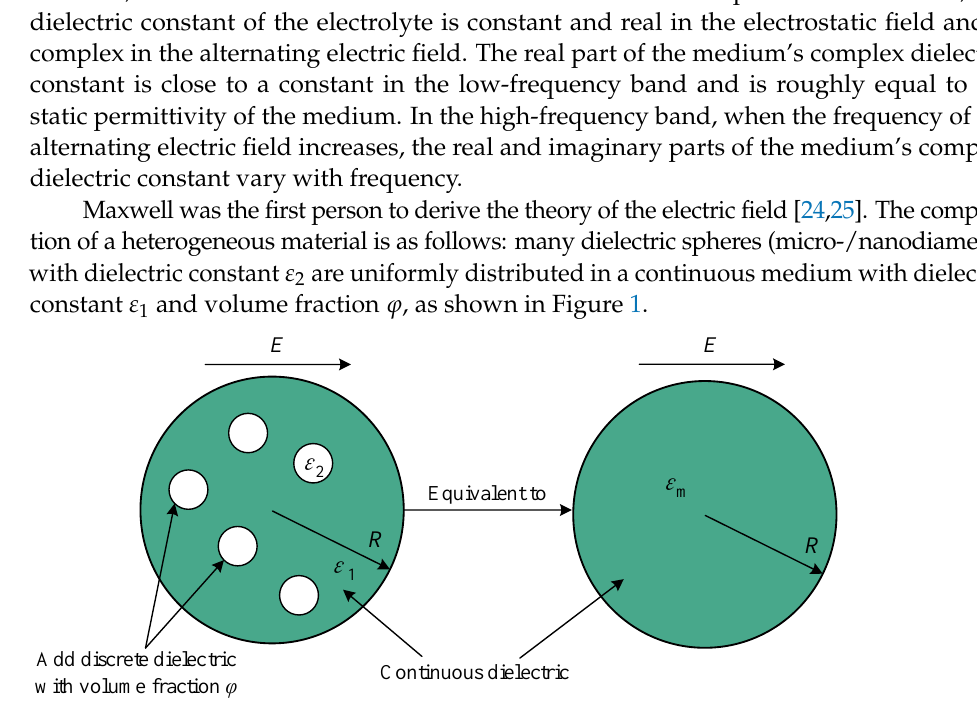
Figure 1. M – W dielectric model. Figure 1. M–W dielectric